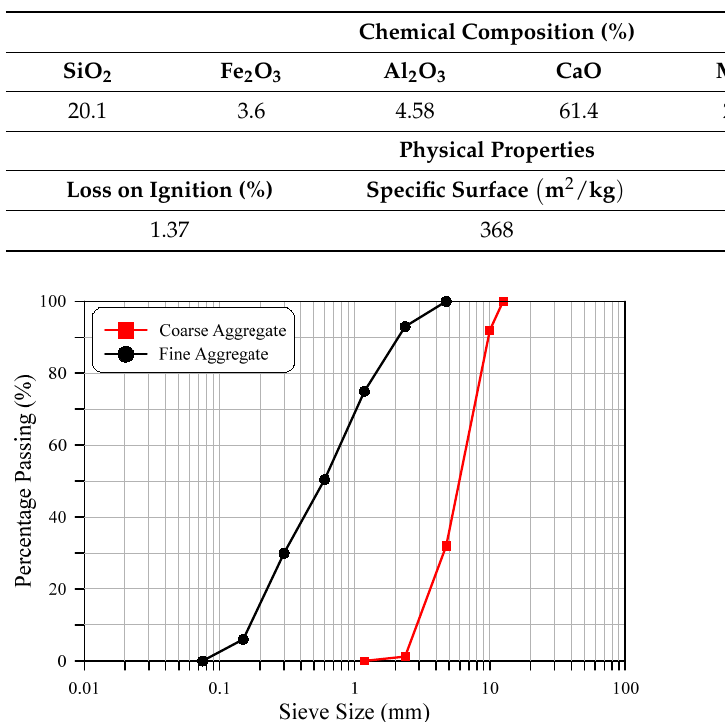
Figure 2. Particle grading of aggregates.